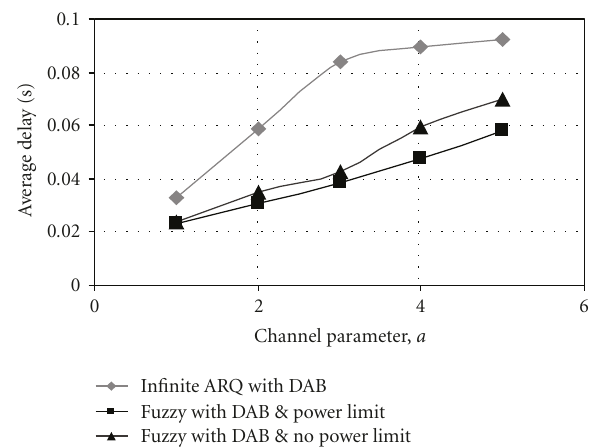
Figure 13: Average packet delay during transmission of the “News” video clip, with the default scheme and the FLC power-aware